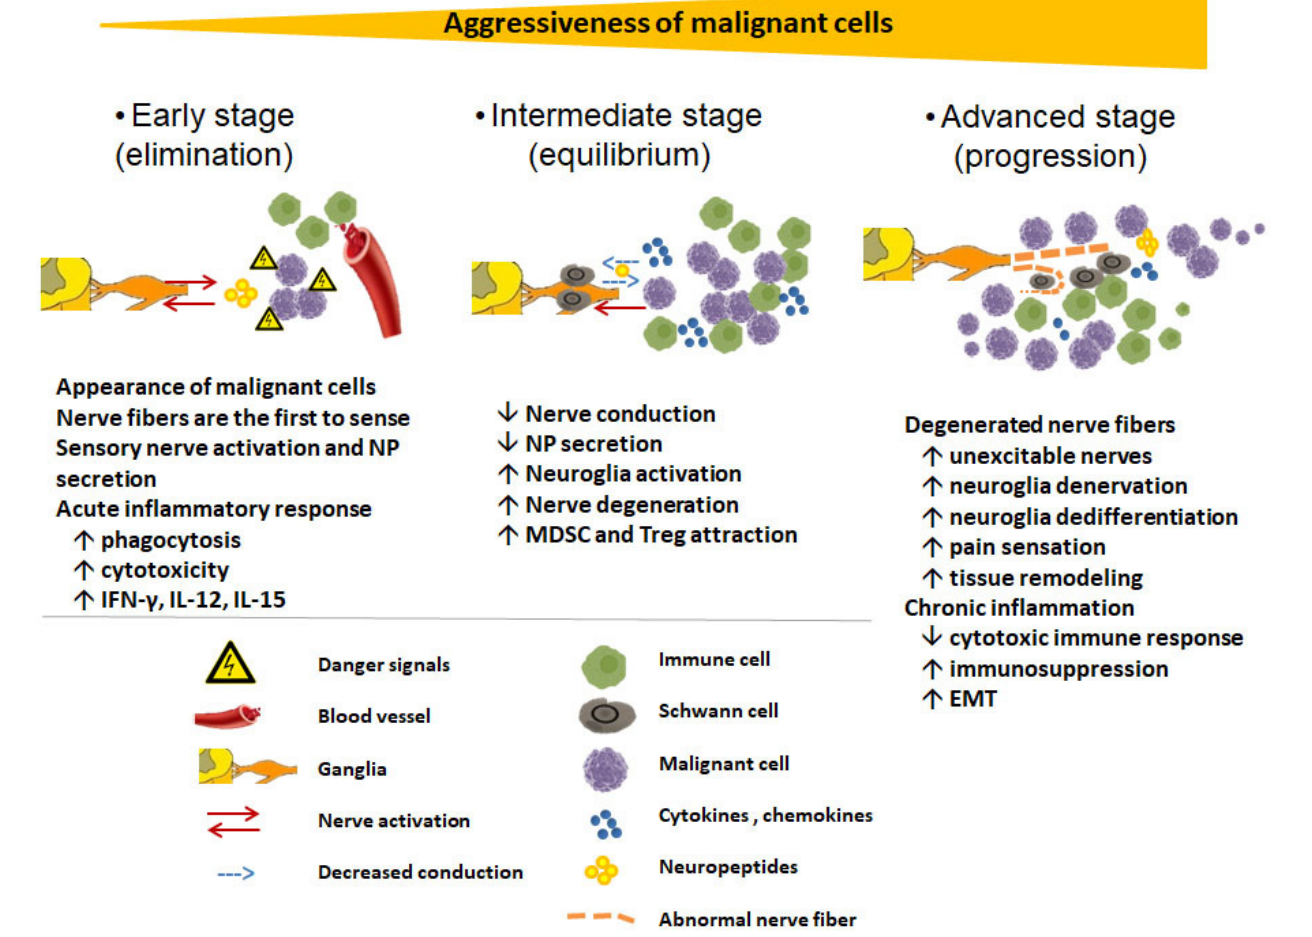
Figure 2. Hypothetical role of sensory nerve fibers in the cancer immune response based on published data. Cancer cells go through immune editing and become more aggressive, while nerve fibers and Schwann cells go through cancer cell editing and become tumorigenic. Free sensory nerve endings of visceral and peripheral tissues are the first to sense the danger signals from pathogens and abnormal cells, inducing an acute inflammatory response as well as the compensatory anti-inflammatory pathway through the hypothalamic–pituitary–adrenal axis in the early stage. In the intermediate stage, partly functioning nerve fibers provide local anti-inflammatory-response cytokines/chemokines released by activated Schwann cells, enhancing cytotoxic immunity. In the advanced stage, complete degeneration of nerve fibers followed by formation of abnormal nerve fibers and tumorigenic Schwann cell activation markedly enhances chronic inflammation, and MDSCs impair cytotoxic immunity and induce